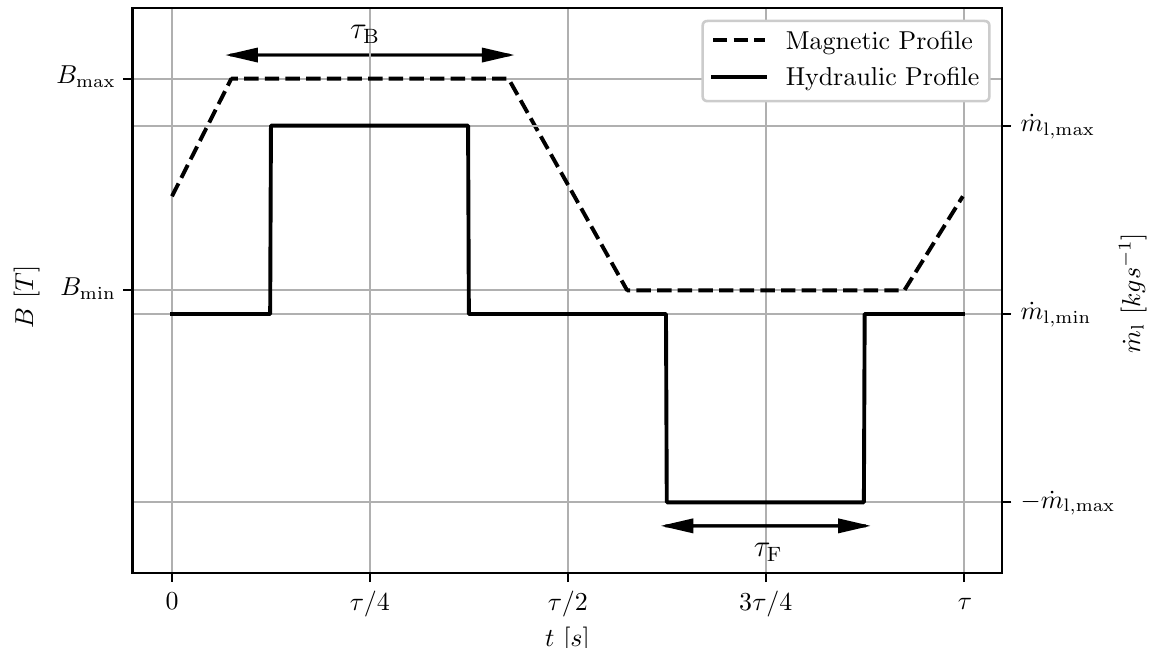
Figure 5. Comparison between the magnetic and hydraulic